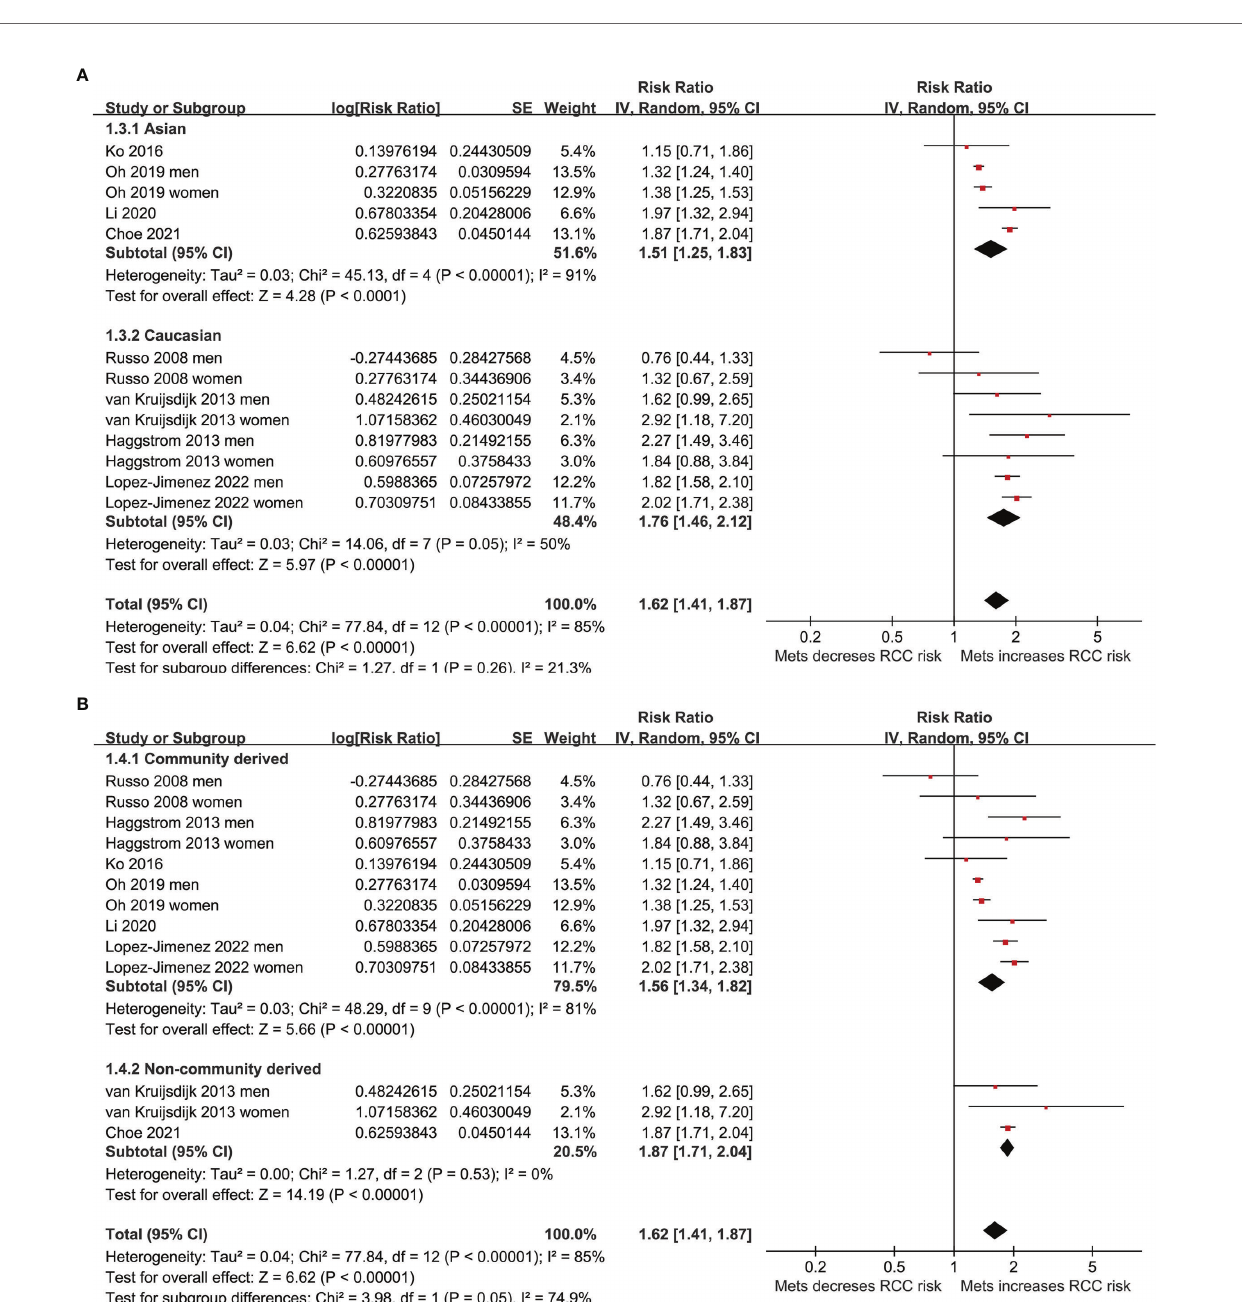
FIGURE 3 | Forest plots for the meta-analysis of the association between MetS and RCC. (A) , subgroup analysis according to the ethnicity of the participants; and (B) , subgroup analysis according to the source of the